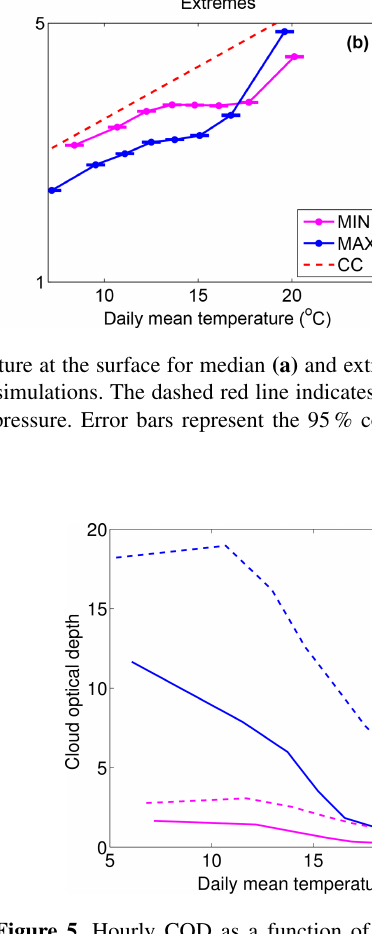
Figure 5. Hourly COD as a function of daily mean temperature for the LR MIN (full magenta line), LR MAX (dashed blue line), HR MIN (dashed magenta line), and HR MAX (dashed blue line)